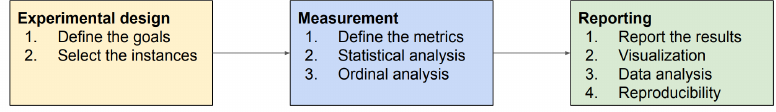
Figure 6. Steps in performance analysis of a